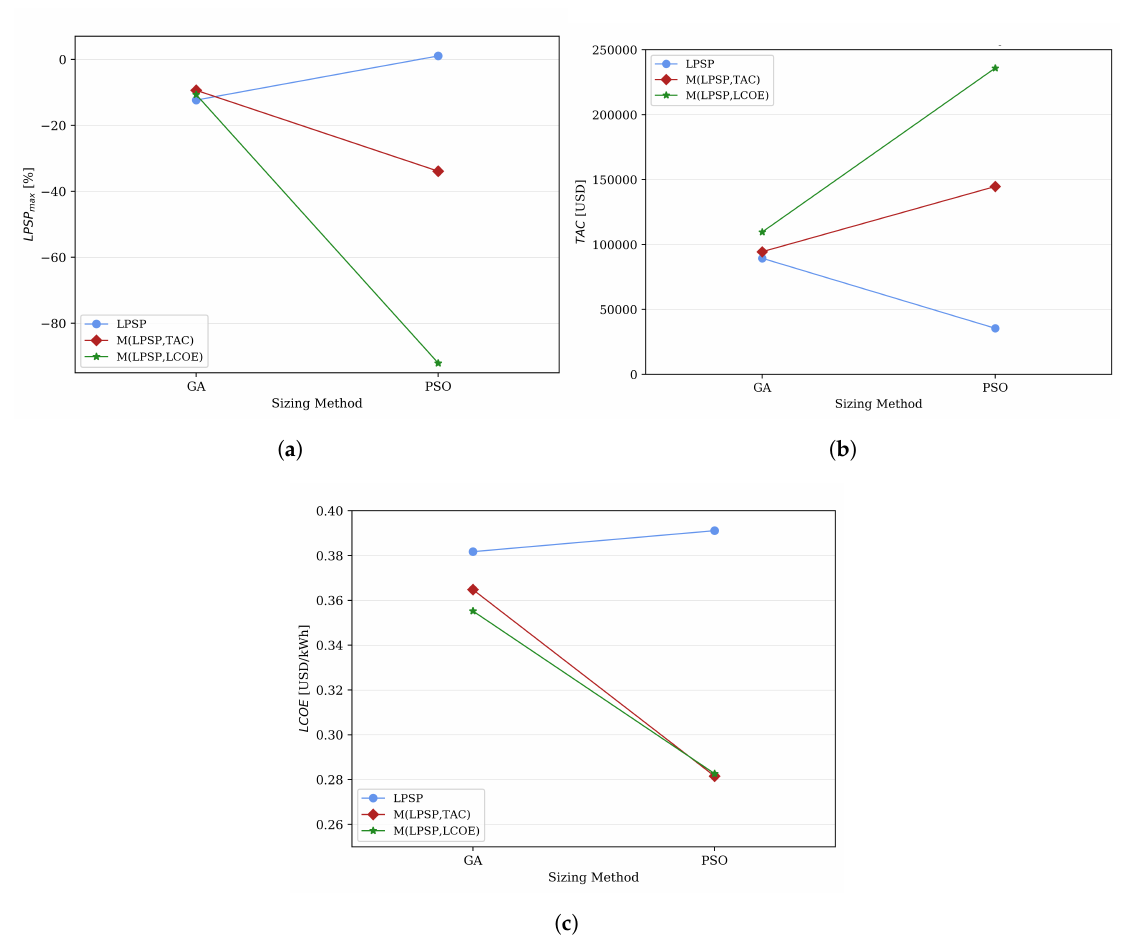
Figure 6. Interaction factors for Case III: community demand of 156.15 kW-h/day. ( a ) LPSP max ( b ) TAC ( c )